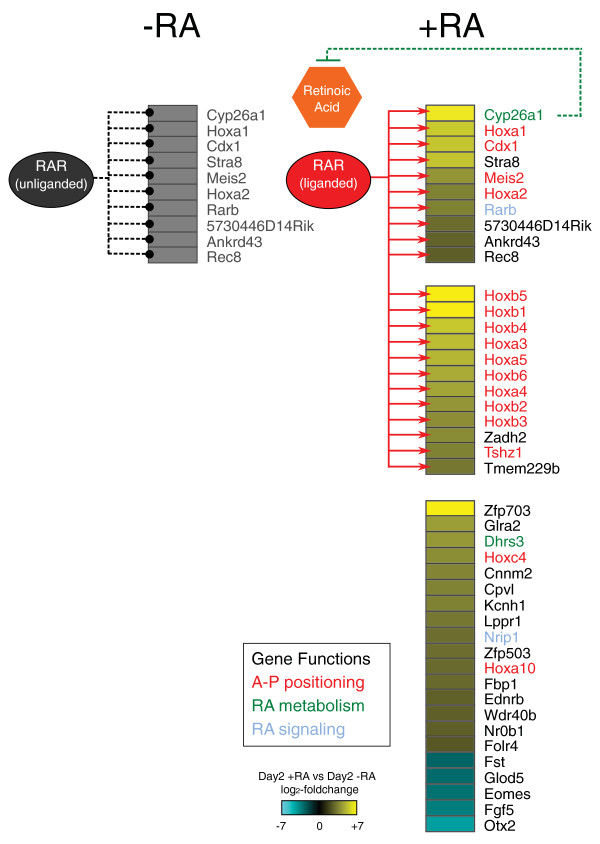
Direct binding of RAR mediates the initial response to RA during early neurogenesis. Genes with more than five-fold differential expression after 8 hours of RA exposure are listed. RAR binds to many of the up-regulated genes, with binding more likely for greater degrees of up-regulation. Red arrows indicate post-RA RAR binding within 20 kbp of the gene. Black dashed lines indicate pre-RA RAR binding within 20 kbp. Three functional groups of genes are indicated by coloring the gene names. Information for all more than two-fold differentially expressed genes is tabulated in Additional file 2.